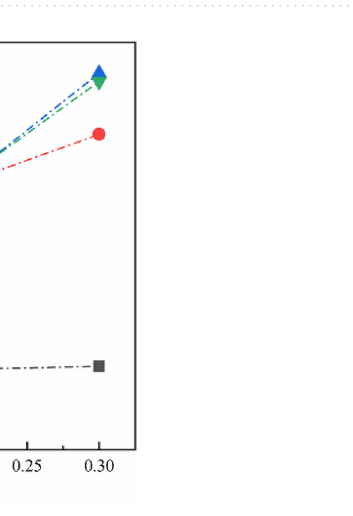
Figure 6. Variation of tensile stress at the front of crack tip with load level under different friction coefficients. Where ( a ) is load level of 500 N; ( b ) is load level of 1000 N; ( c ) is load level of 1500 N; and ( d ) is load level of 2000 N. Red dotted lines indicates the tensile stress determined by stress intensity factor that in the friction-free condition.